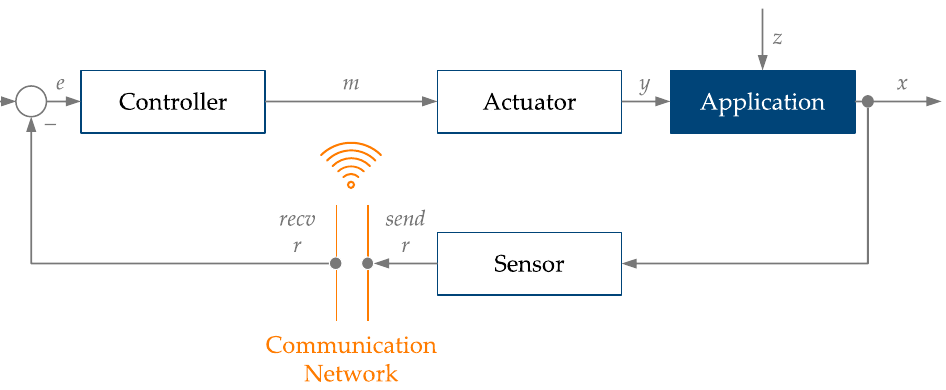
Figure 2. Architecture of the networked control system being referred to in this paper [21].